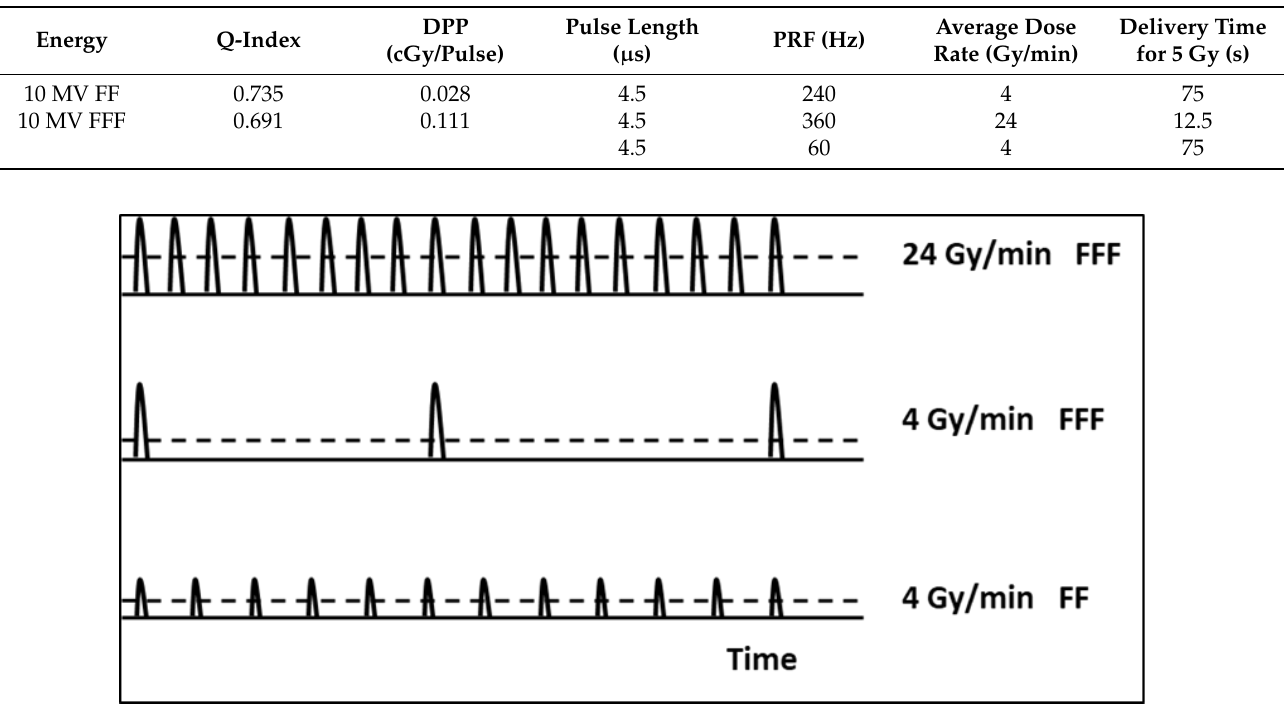
Figure 6. Schematic representation of pulse rates giving the same mean dose in different beam configurations (10 MV TrueBeam).